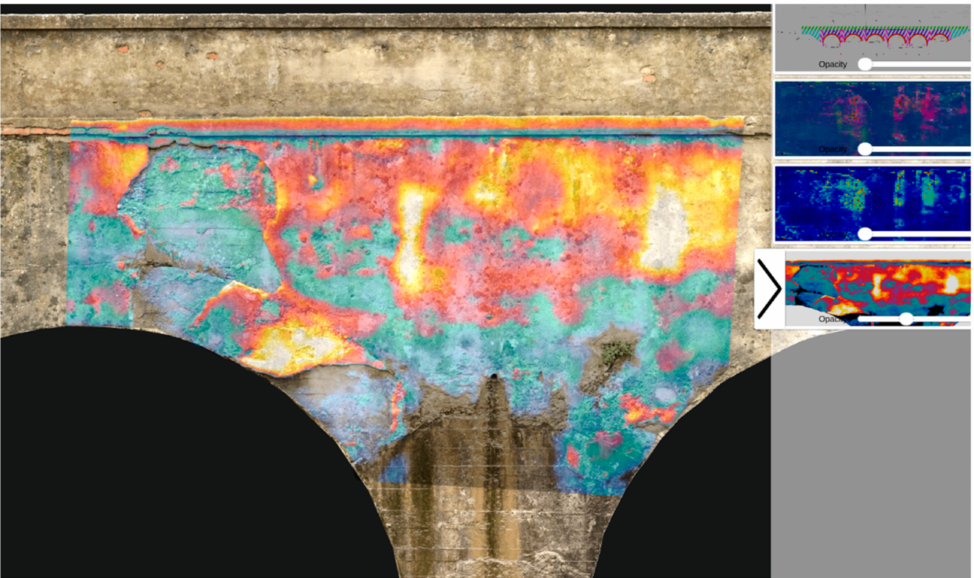
Figure 3. TOSCA-FI Software Platform: 2D heatmap overlays on a 3D digital bridge model